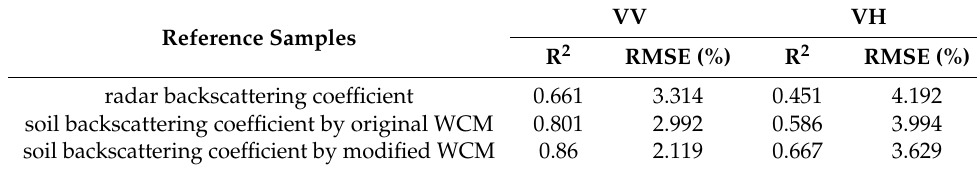
Figure 5. Graph of relationship between VV, VH polarization backscattering coefficients. ( a ) VV polarization. ( b ) VH polarization. Table 3. Summary of results for different reference samples by